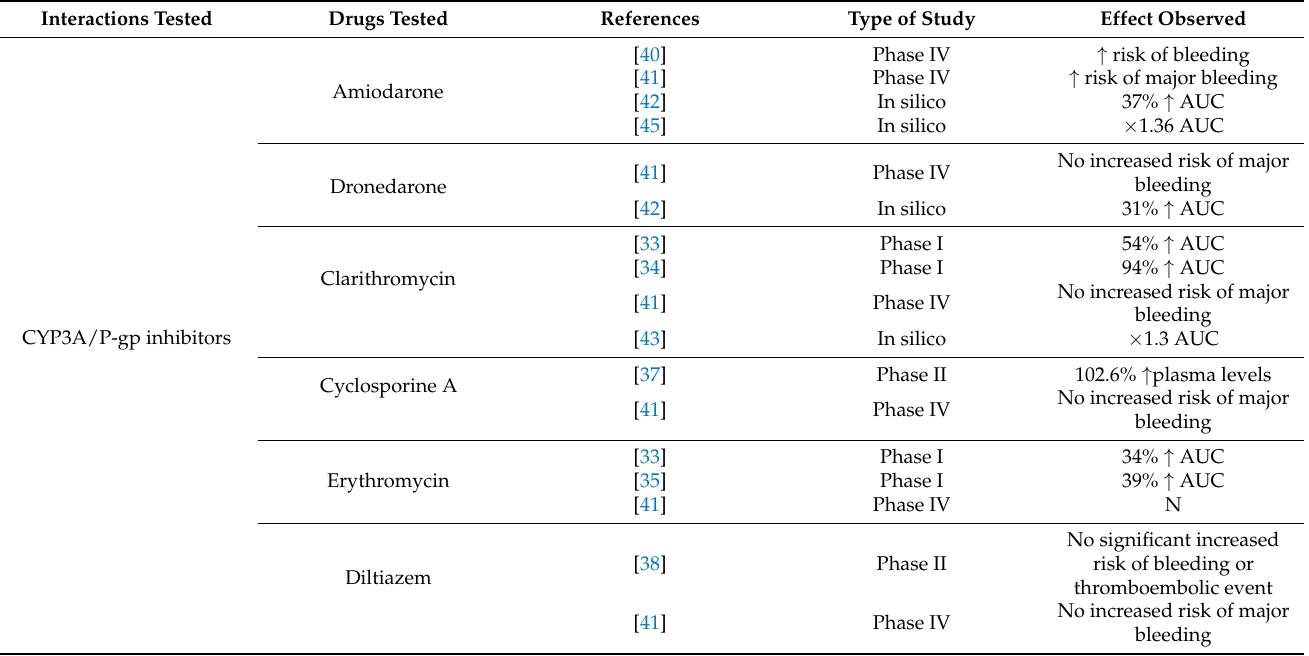
Table 2. Summary of DDIs involving